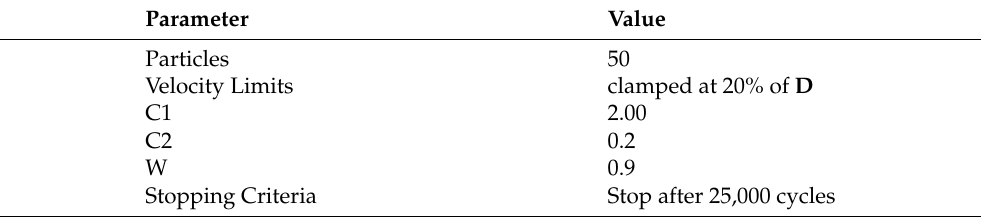
Table 9. PSO settings for the distortion correction task. Ranges per component of this search space D are reported in Table